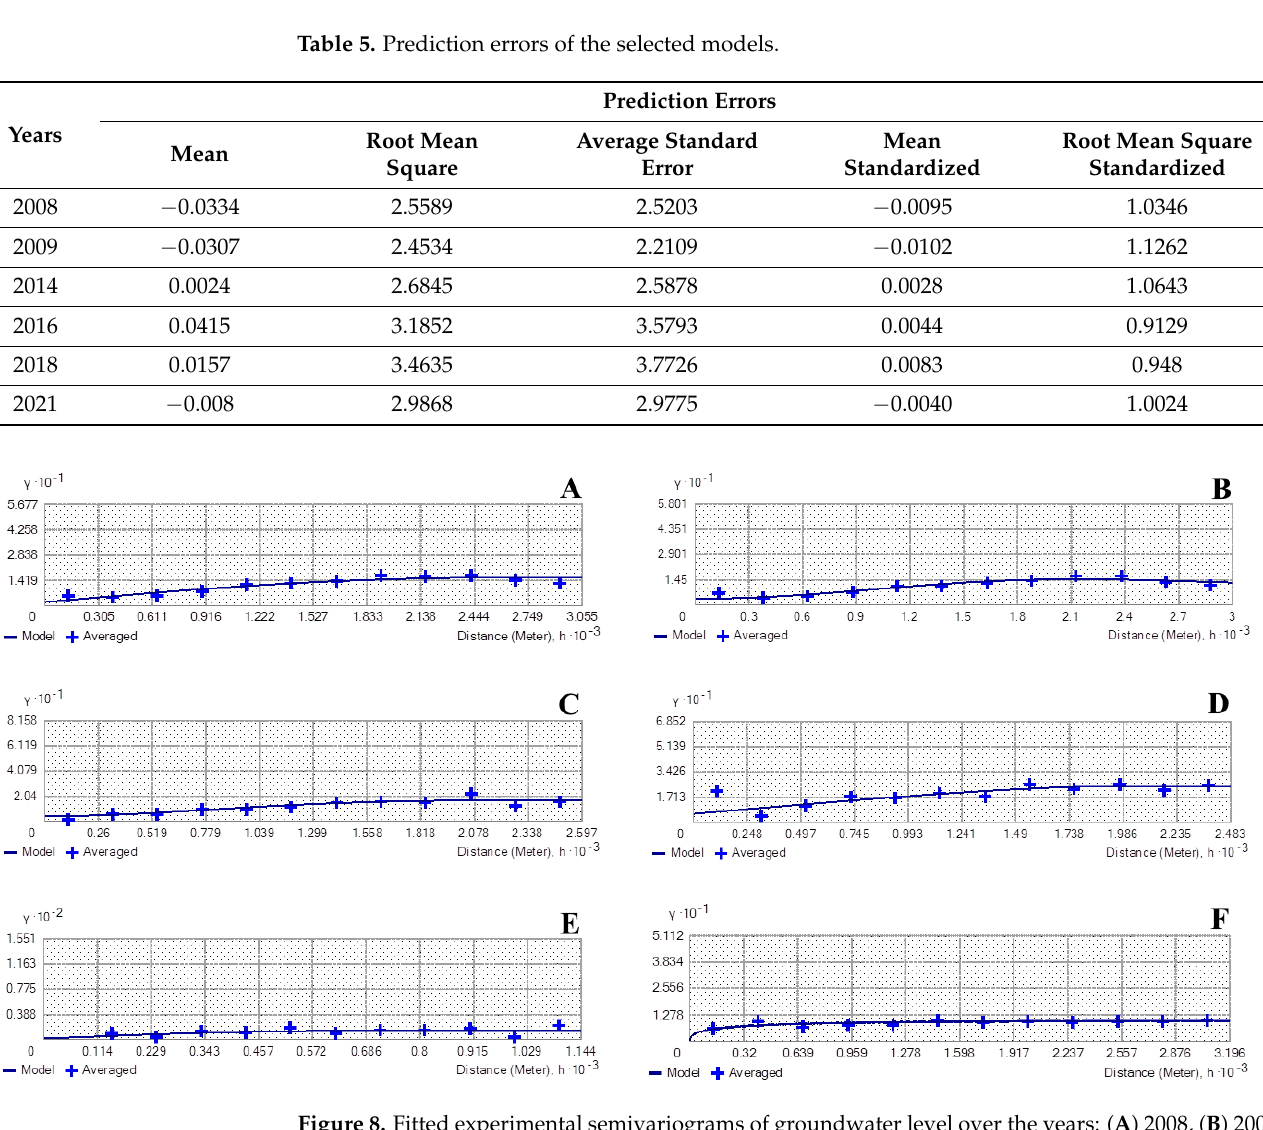
Figure 8. Fitted experimental semivariograms of groundwater level over the years: ( A ) 2008, ( B ) 2009, ( C ) 2014, ( D ) 2016, ( E ) 2018, ( F ) 2021.